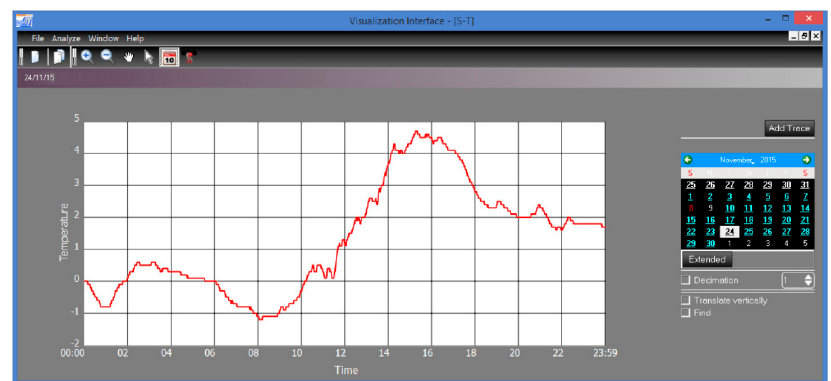
Figure 25. Example of visualization of sensor records for one day (external air temperature). Agronomy 2020 , 10 , 936